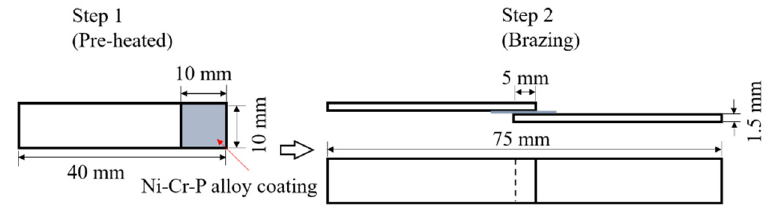
Figure 1. Geometry and dimensions of specimen for brazing.